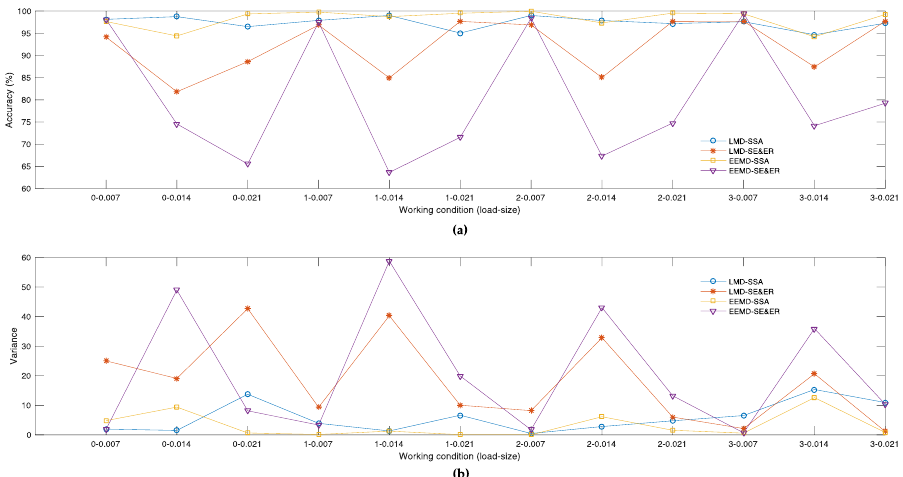
Figure 5. ( a ) Average diagnostic accuracy of all independent experiments corresponding to 12 different working conditions respectively in 1st – 4th experimental sets. ( b ) Variance of diagnostic accuracy of all independent experiments corresponding to 12 different working conditions respectively in 1st – 4th experimental